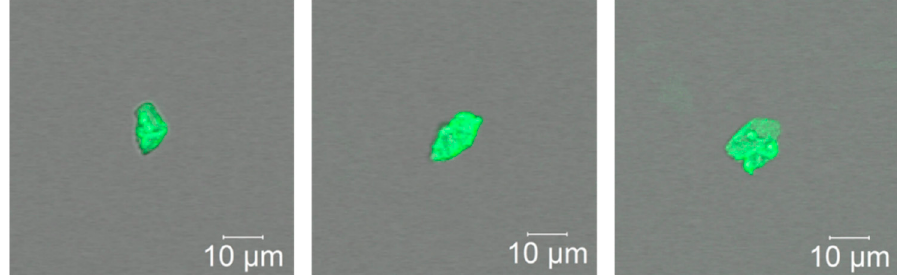
Figure 5. Fluorescent images of the liquid phase of 0.038 mol·dm − 3 CaCl 2 solution with 10 mg·dm − 3 PAA-F2 after 24 h thermal treatment. Scale marker corresponds to 10 µm.